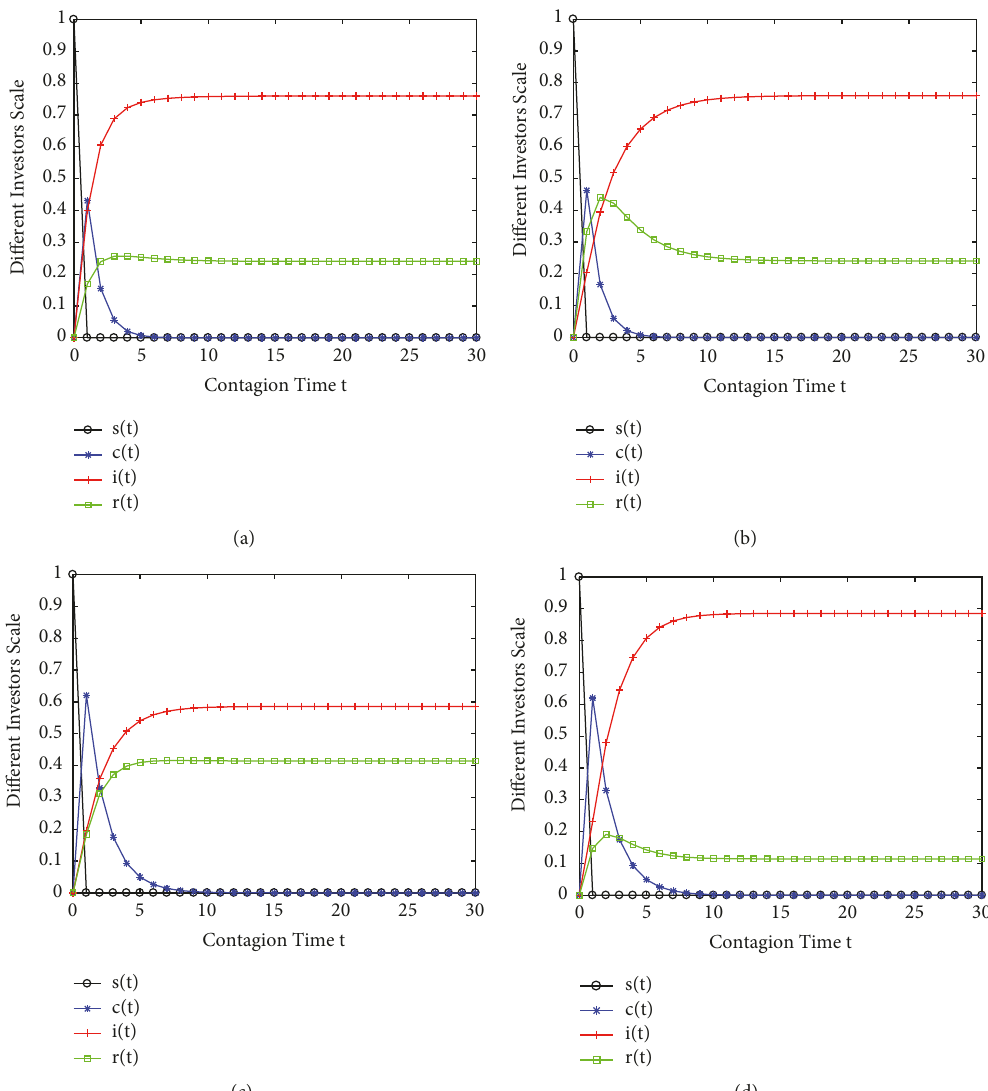
Figure 7: Investor scale trends in different states of SCIR investor risk contagion model in the stock market under different mechanism probability